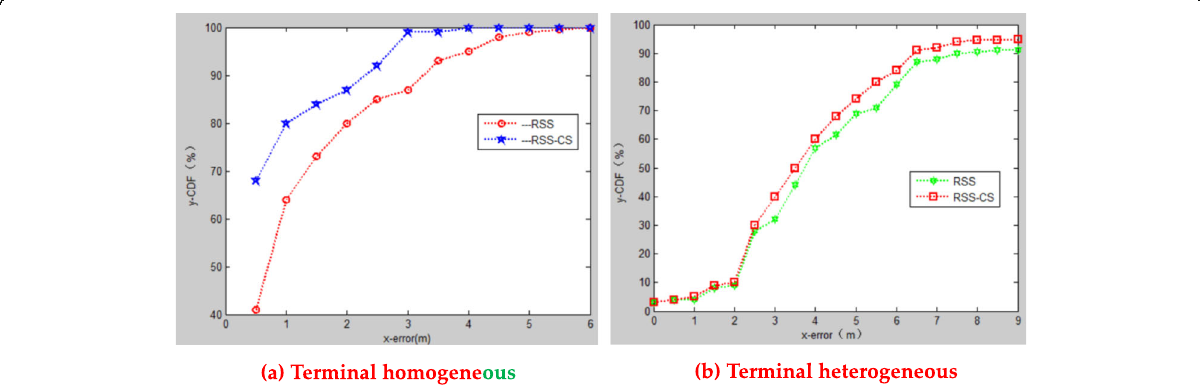
Fig. 6 Comparison of RSS-based using compressive sensing localization performance. a Terminal homogeneity. b Terminal